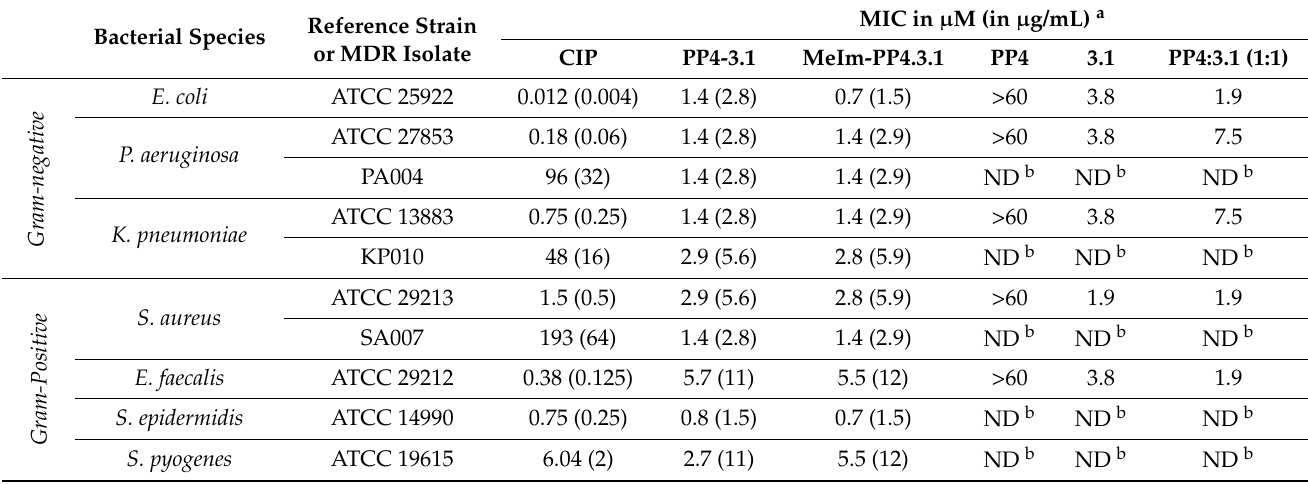
Table 2. Activity of the peptide constructs against susceptible and MDR Gram-positive and Gram-negative bacteria